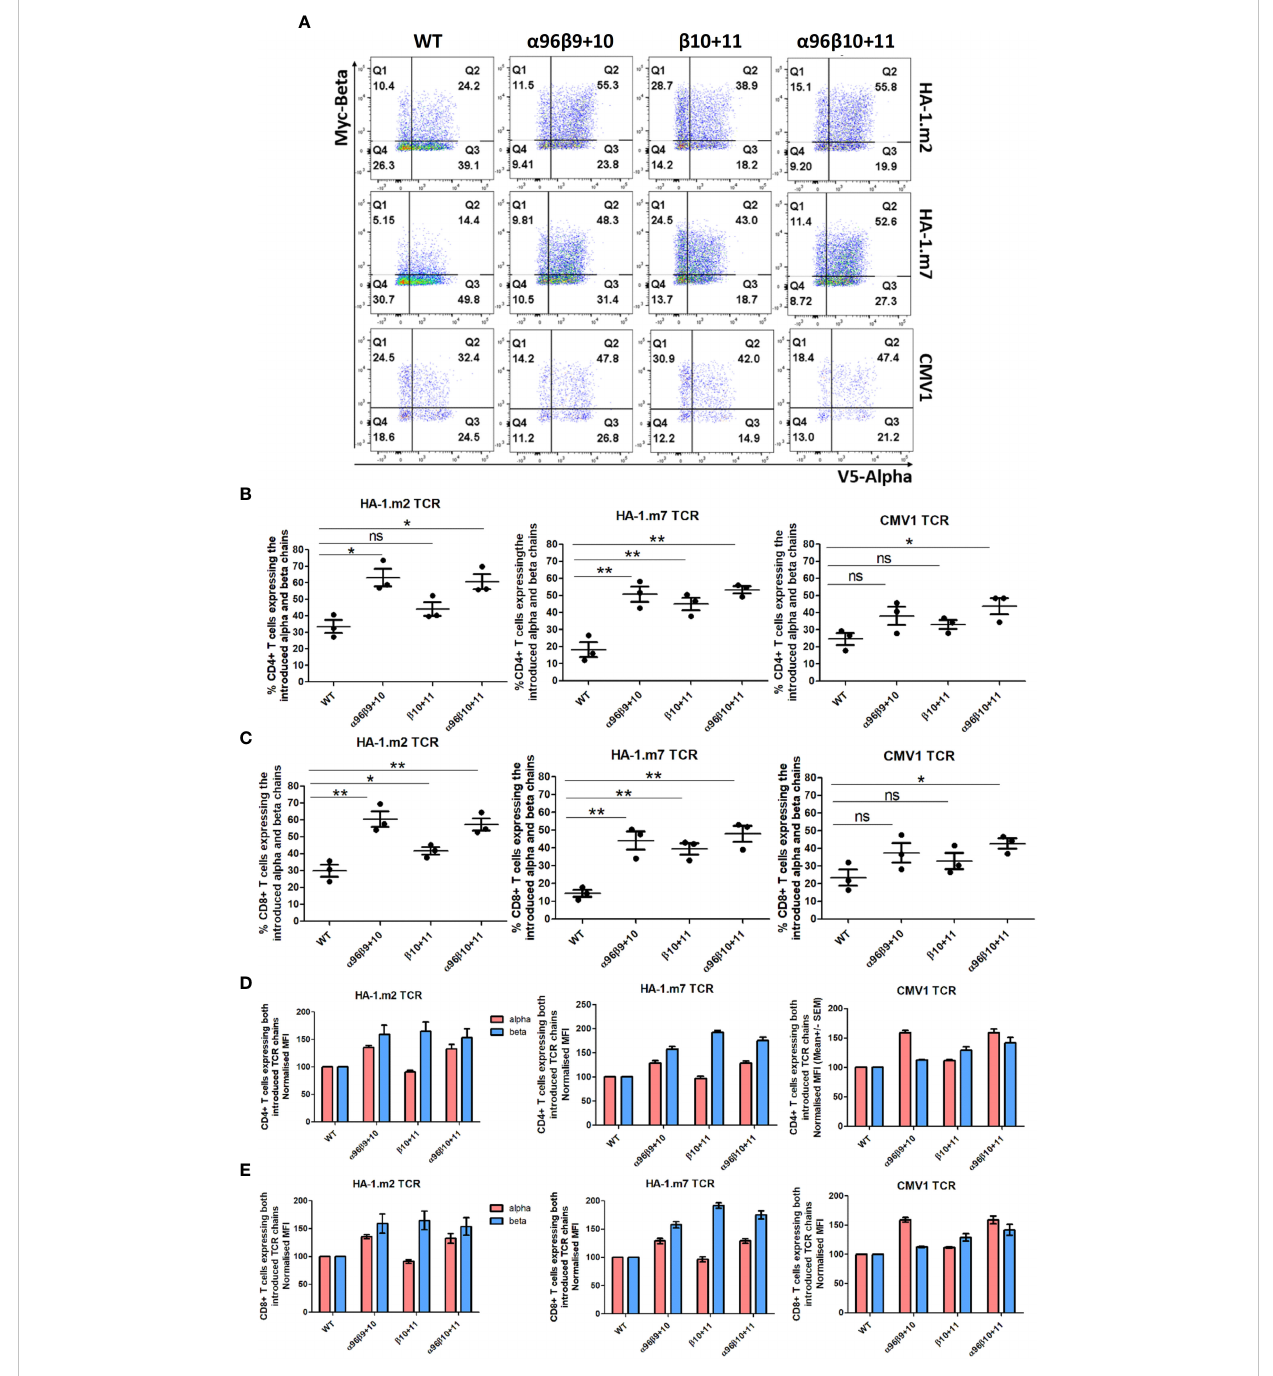
FIGURE 4 Alpha and beta chain residue modi fi cations elevated introduced TCRs expression and reduced mis-pairing in human primary T cells. Human activated PBMCs were transduced with either WT TCR or TCRs with the indicated modi fi ed residue changes for 3 antigen speci fi c TCRs (CMV1 pp65, HA1.2 and HA1.m7). Shown are representative examples of three independent experiments. (A) FACS plot show introduced TCR a chain and TCR b chain expression in CD8+CD19+ gated cells. (B) Graphs show the percentage of cells expressing both the introduced a chain and introduced b chain in CD4+CD19+ gated T cells. Unpaired t test, *: p<0.05, **: p<0.01, ns: non-signi fi cant. (C) Graph show the percentage of cells expressing both the introduced a chain and introduced b chain in CD8-CD19+ gated T cells. Unpaired t test, *: p<0.05, **: p<0.01, ns: non-signi fi cant (D) The MFI (Mean+/- SEM) values of the introduced TCR a and TCR b chain in CD8+CD19+ gated T cells. MFI values are normalised to WT expression. (E) The MFI (Mean+/- SEM) values of the introduced TCR a and TCR b chain in CD4+CD19+ gated T cells. MFI values are normalised to WT